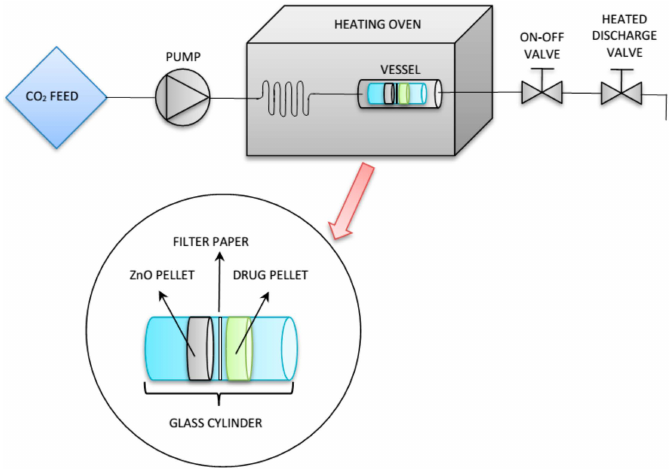
Figure 1. Experimental apparatus for supercritical solvent impregnation